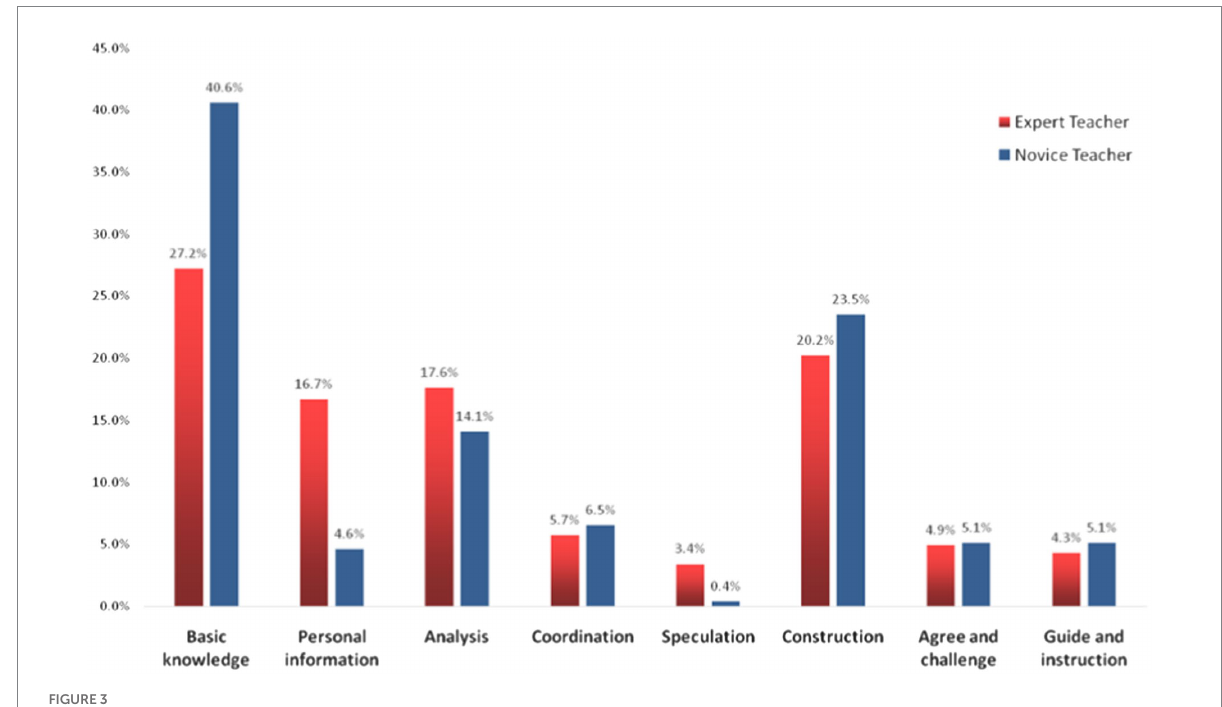
FIGURE 3 Distribution of dialogs types between expert and novice teachers’